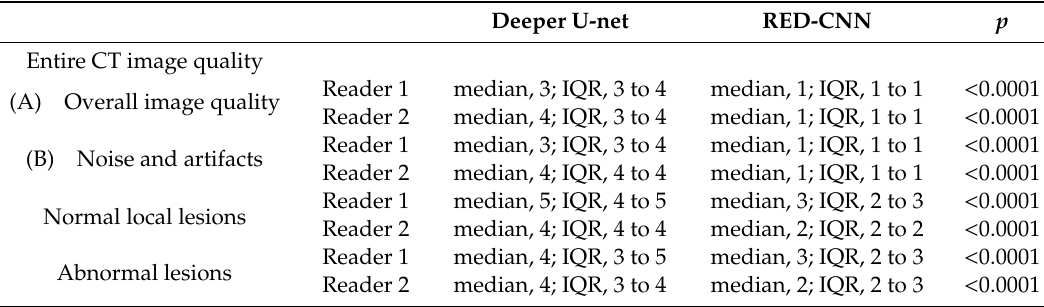
Table 7. Results of visual evaluations by the two readers using different deep learning algorithms.